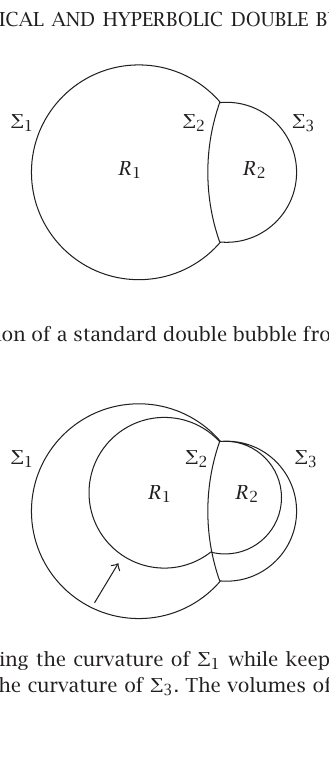
1 while keeping the curvature of Σ 3 . The volumes of R 1 and R 2 both de-